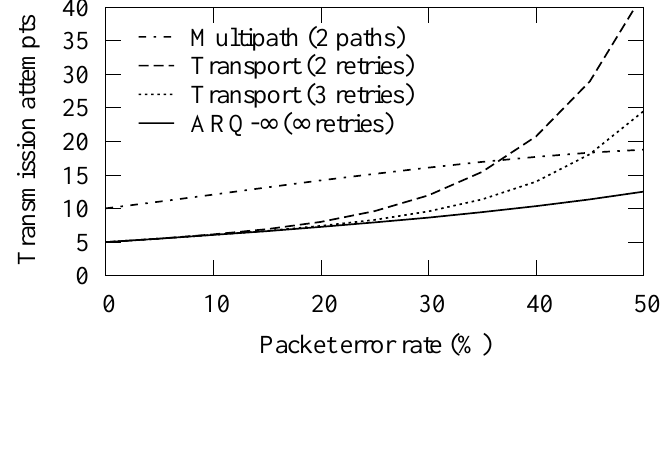
Figure 19. Complexity of different routing schemes with a route consisting of 5 hops having equal packet error